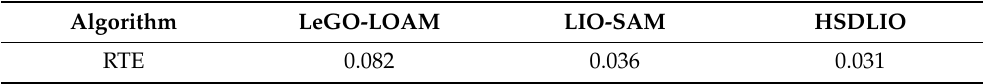
Table 3. Relative translational error when the backpack returns to the starting point (meters).